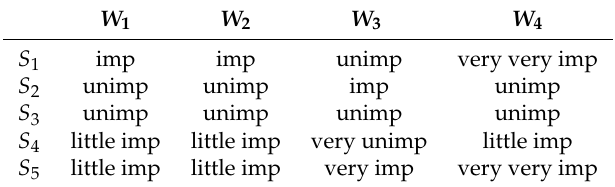
Table 2. Linguistic values of the objective function corresponding to robot actions. W 1